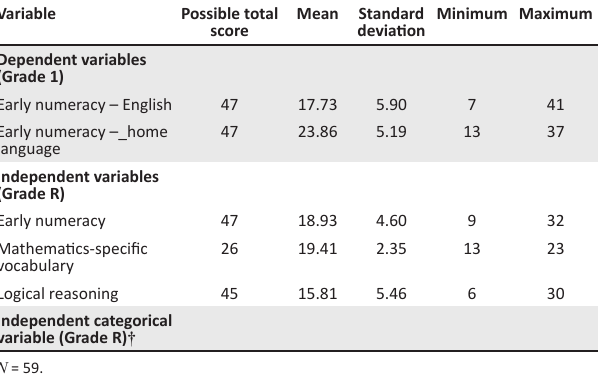
TABLE 1: Descriptive statistics for independent, dependent and control variables.